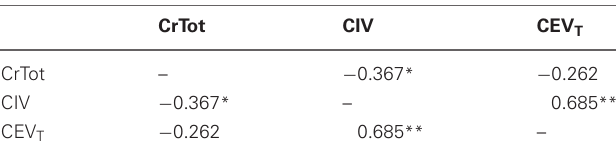
Table 1 | Results of the bivariate correlation analyses between CEV T , CIV, and CrTot. CrTot CIV